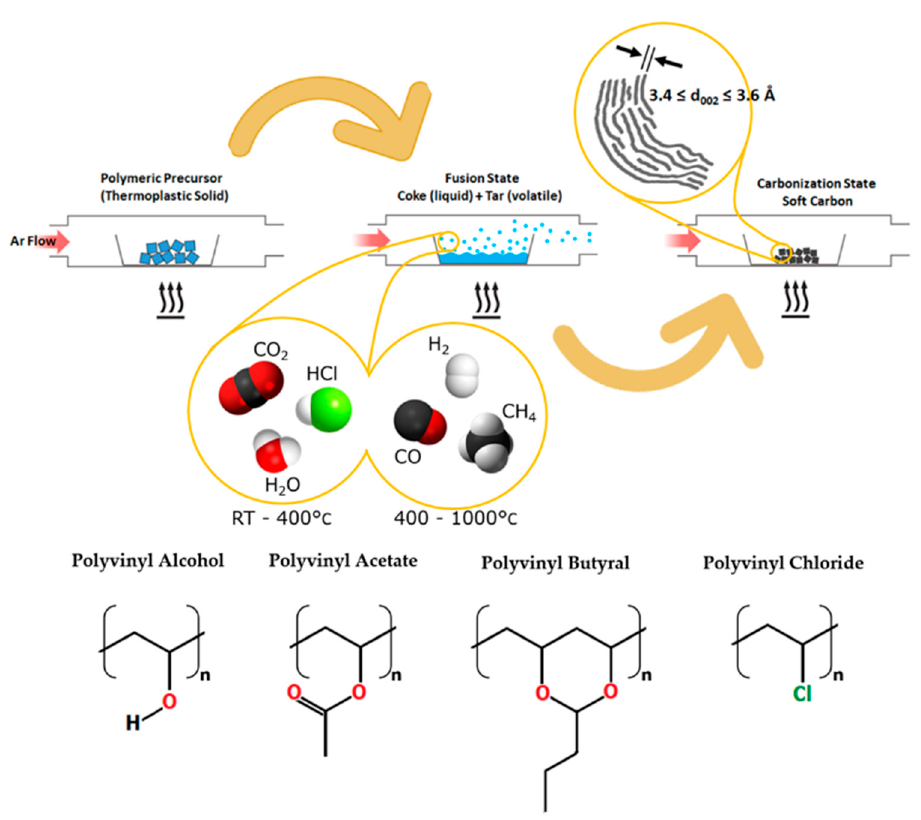
Figure 1. Schematic illustration for pyrolysis of a thermoplastic polymer, resulting in the exclusion of volatiles in various stages and formation of soft carbon with large local crystalline parallel graphene layers; and repeating unit in di ff erent polyvinyl family members studied in this work. The C 4 H 8 O as the expelled gas (e.g., in the case of PVB) is not shown for the sake of simplicity.